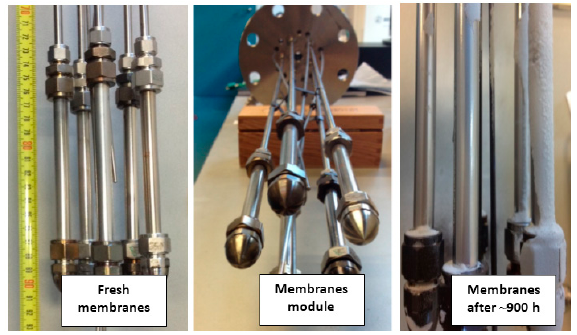
Figure 11. Fresh membranes surface and after 900 h of continuous operation under bubbling fluidization conditions and high temperature WGS.